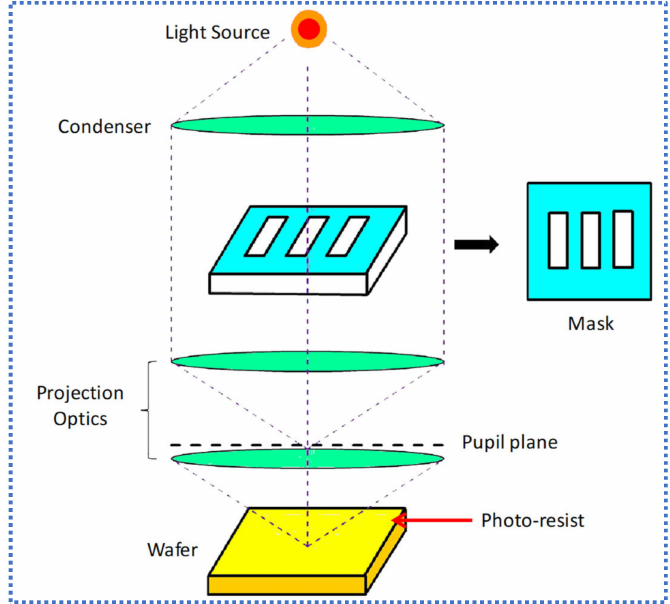
Figure 2. Schematic of optical